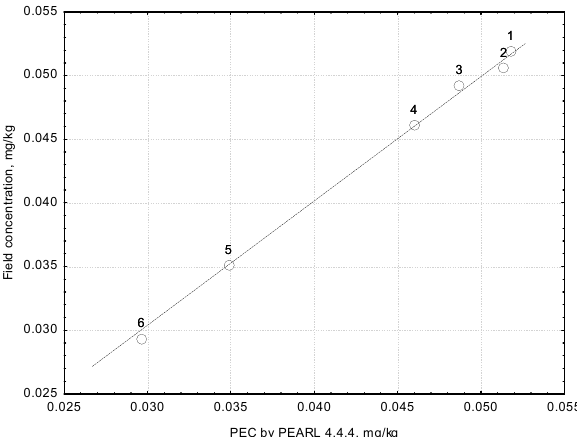
Figure 5. Dependence of the real values on the PEARL 4.4.4 predicted values.